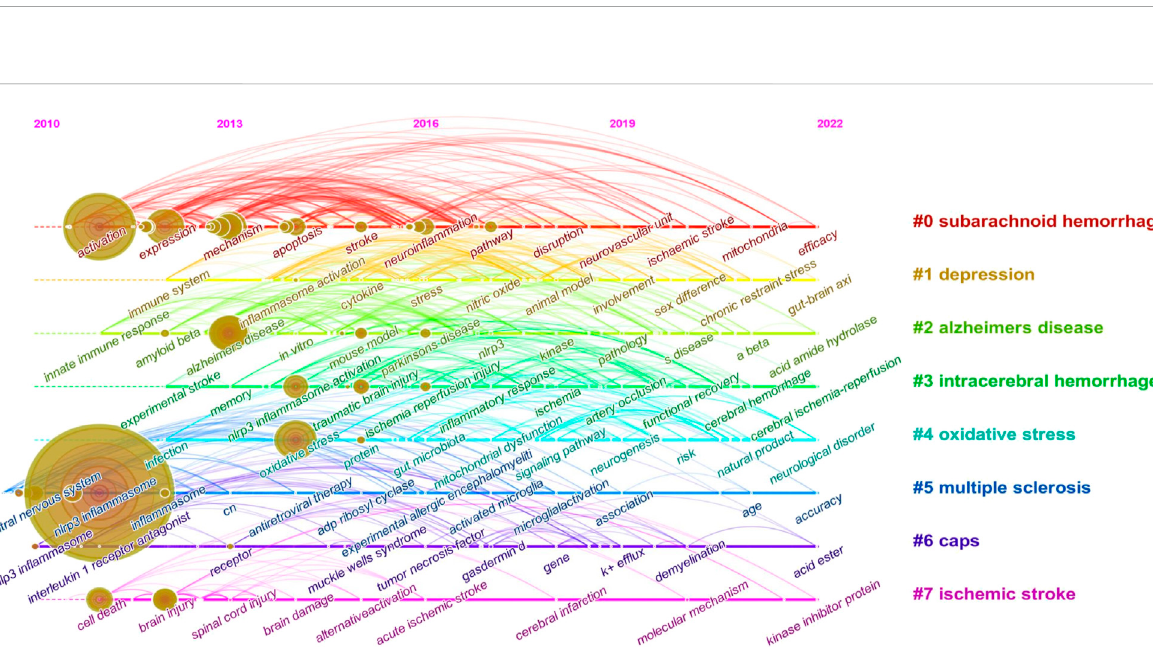
FIGURE 8 Keyword cluster timeline analysis (2010 – 2022). There are eight clusters in total and distinguished by different colors. Cluster #0 is the largest cluster, followed by cluster #1, and so on. This timeline chart spreads out the keywords included in the clusters by the time they emerged. The keyword color is the same as the label color of the cluster to which it